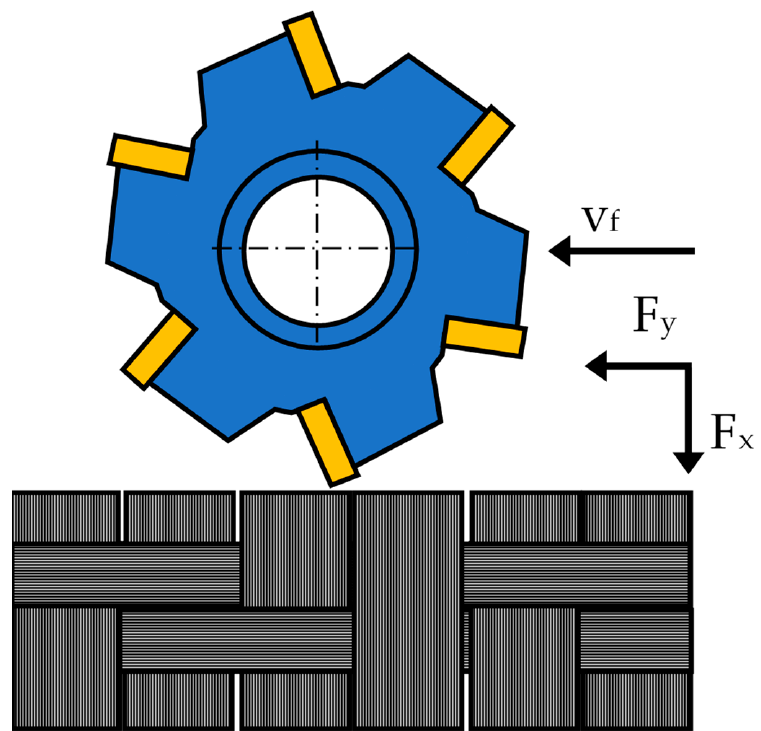
Figure 5. Orientation of the milling tool to the warp yarn.